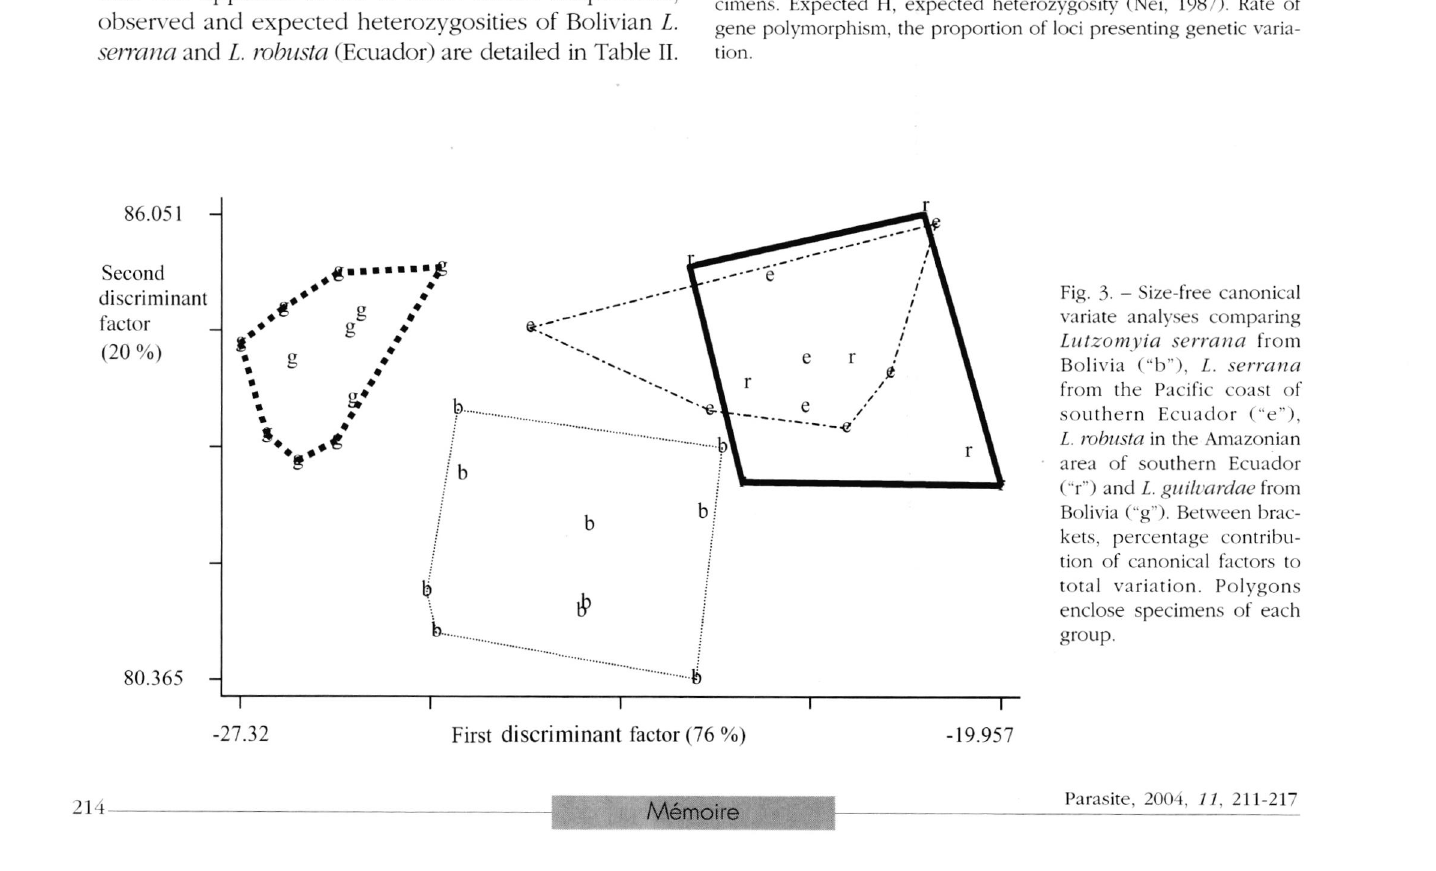
Fig. 2. - Range of variation of each group along the first common principal component, representing allometric change of size common to the four groups. Each box shows the group median separating the 25 th and 75 th quartiles, with the 10 th and 90 th quartiles shown as lines on the right and left sides of the box.